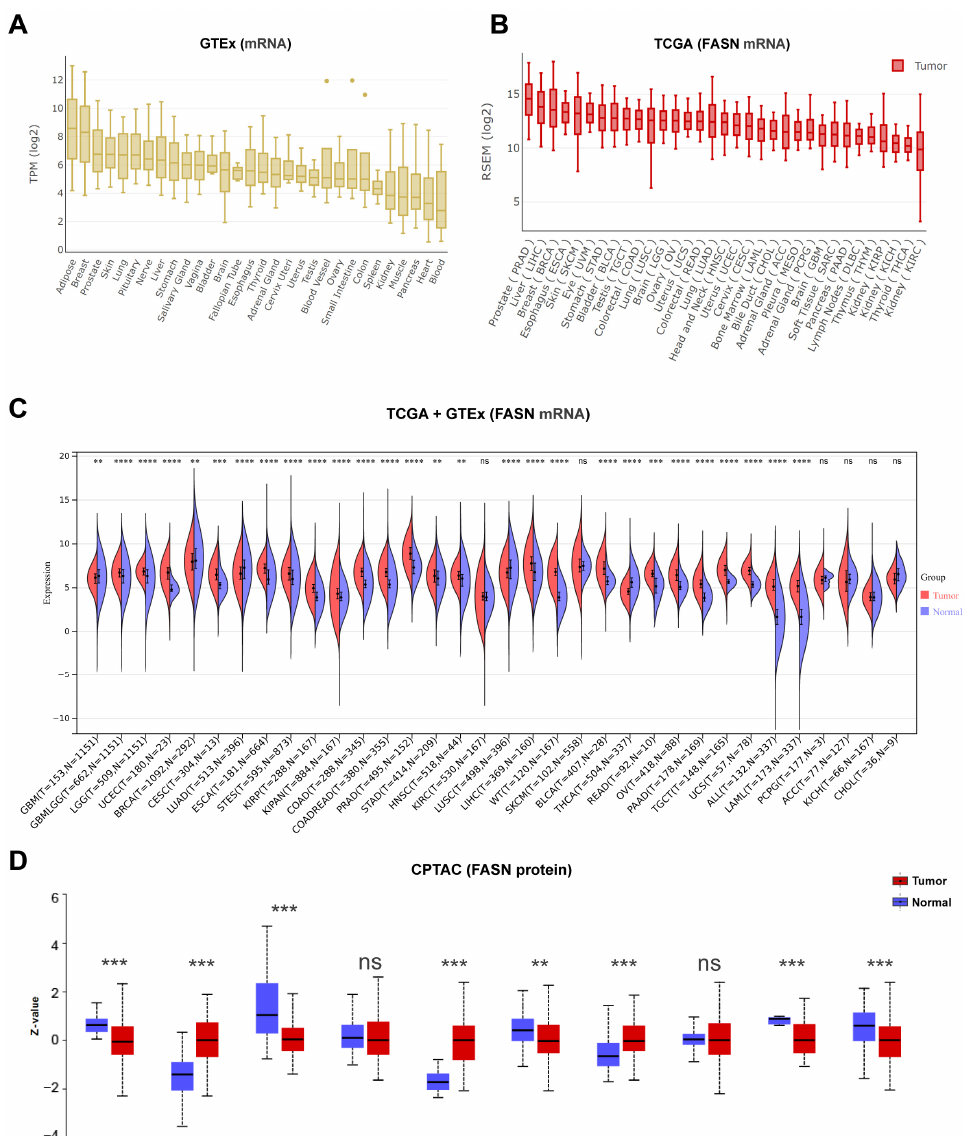
Figure 1. FASN expression profiles in normal tissues and cancers. ( A ) FASN expression levels in normal tissues and organs. ( B ) Profiles of FASN expression in 33 cancer types. ( C ) Sangerbox3.0 database indicated that the FASN expression in 34 cancer types. ( D ) The total protein level of FASN in normal tissue and breast cancer, colon cancer, ovarian cancer, clear cell RCC, UCEC, lung cancer, pancreatic cancer, head and neck cancer, glioblastoma, and liver cancer (** p < 0.01, *** p < 0.001, **** p < 0.0001, ns: p > 0.05.).